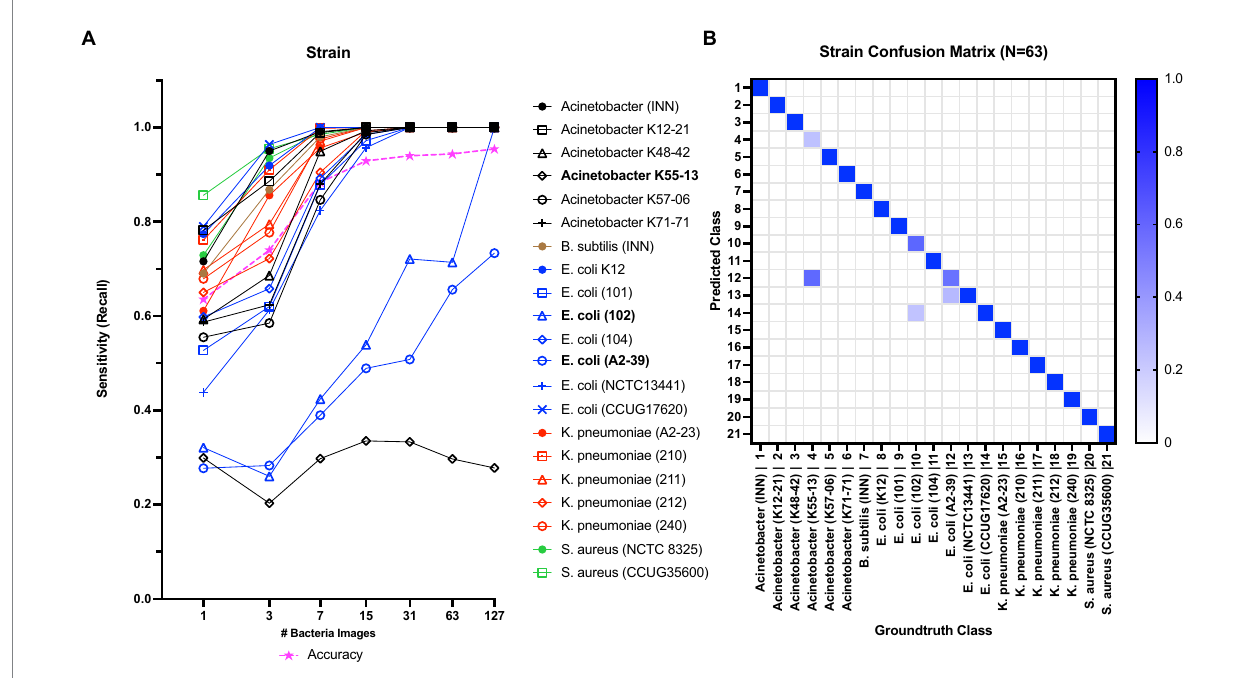
FIGURE 8 (A) Strain level classification sensitivity scores against the number of bacterial QPM images (B) Confusion matrix for strain-level classification with 63 bacterial QPM images in the batch. The WGS data provide the ground truth class information.